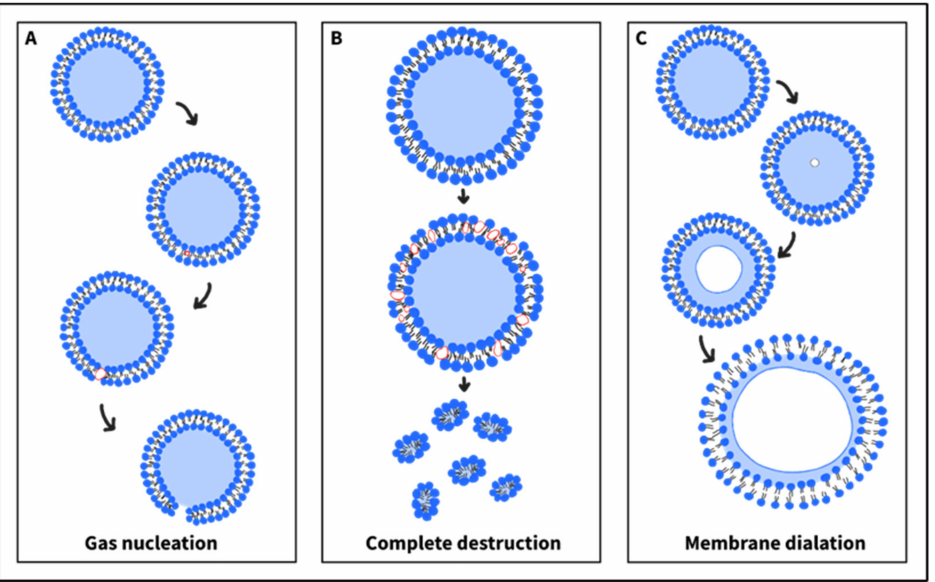
Figure 7. ( A ) Ultrasound might initiate gas nucleation within the lipid bilayer. Subsequent expansion of these gas nuclei during the ultrasound’s negative pressure might result in pore formation in the membrane. ( B ) Multiple poration within the bilayer may lead to its destruction, which might be followed by the formation of micelles. ( C ) The ultrasound rarefaction phase might vaporize dissolved gases or evaporate water in the aqueous core of the liposomes. When expanded, they dilate the bilayer, thus enhancing its overall